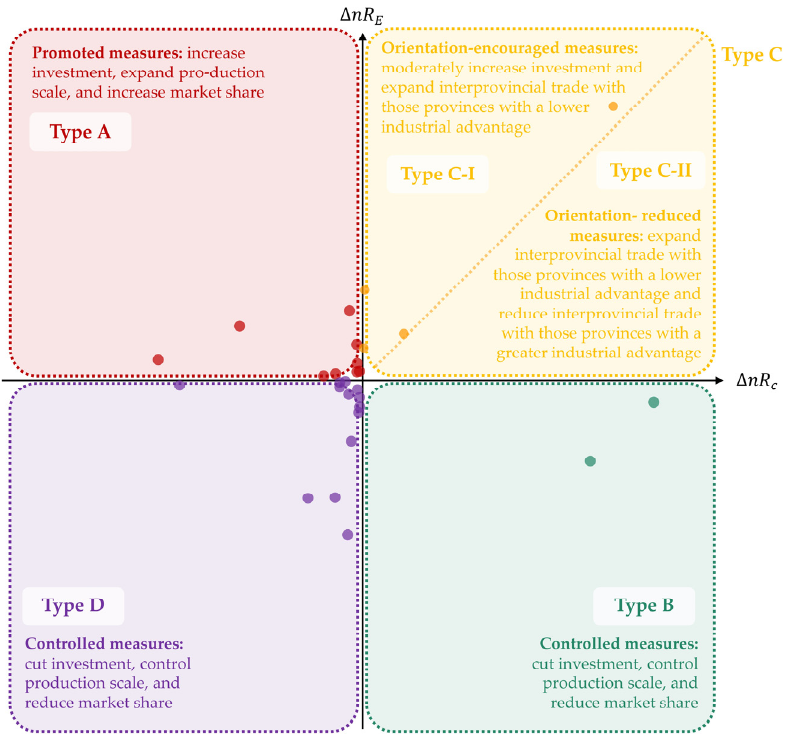
Figure 9. Improvement measures for each industrial